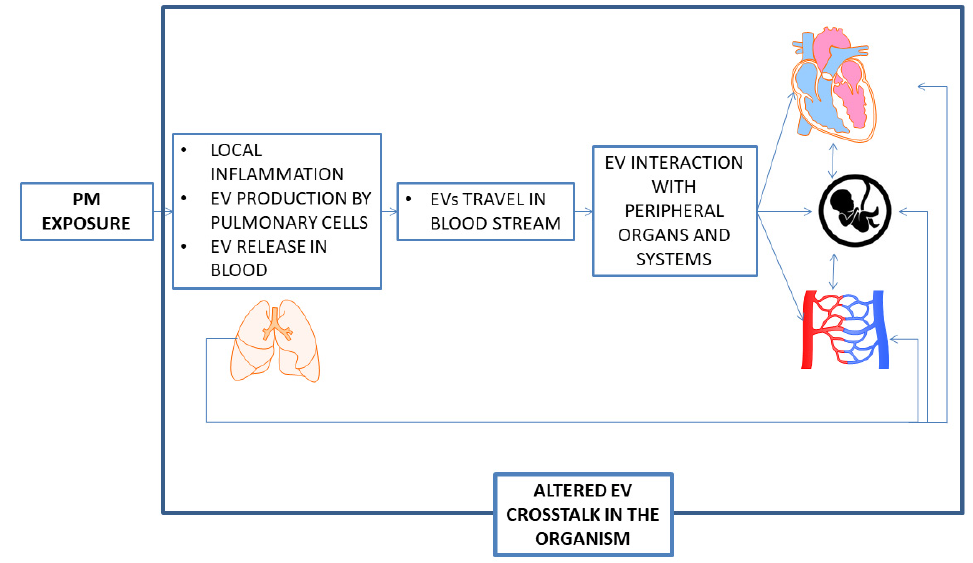
Figure 1. Rationale of the INSIDE project. PM: Particulate Matter; EV: Extracellular Vesicles.